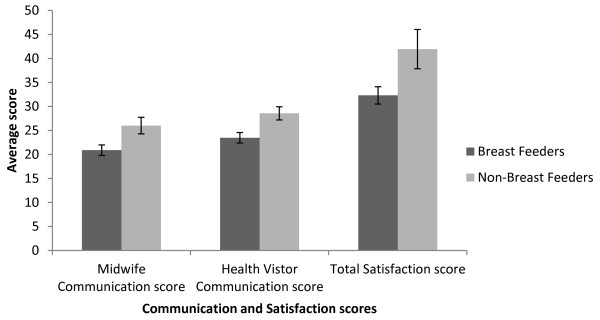
Mean total satisfaction with postnatal care and communication ratings for breastfeeding mothers and those who were not breastfeeding. Error bars represent standard errors.